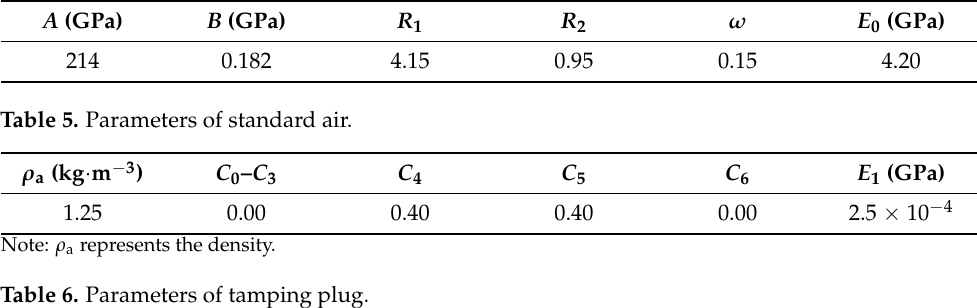
Table 4. Parameters of JWL state equation.